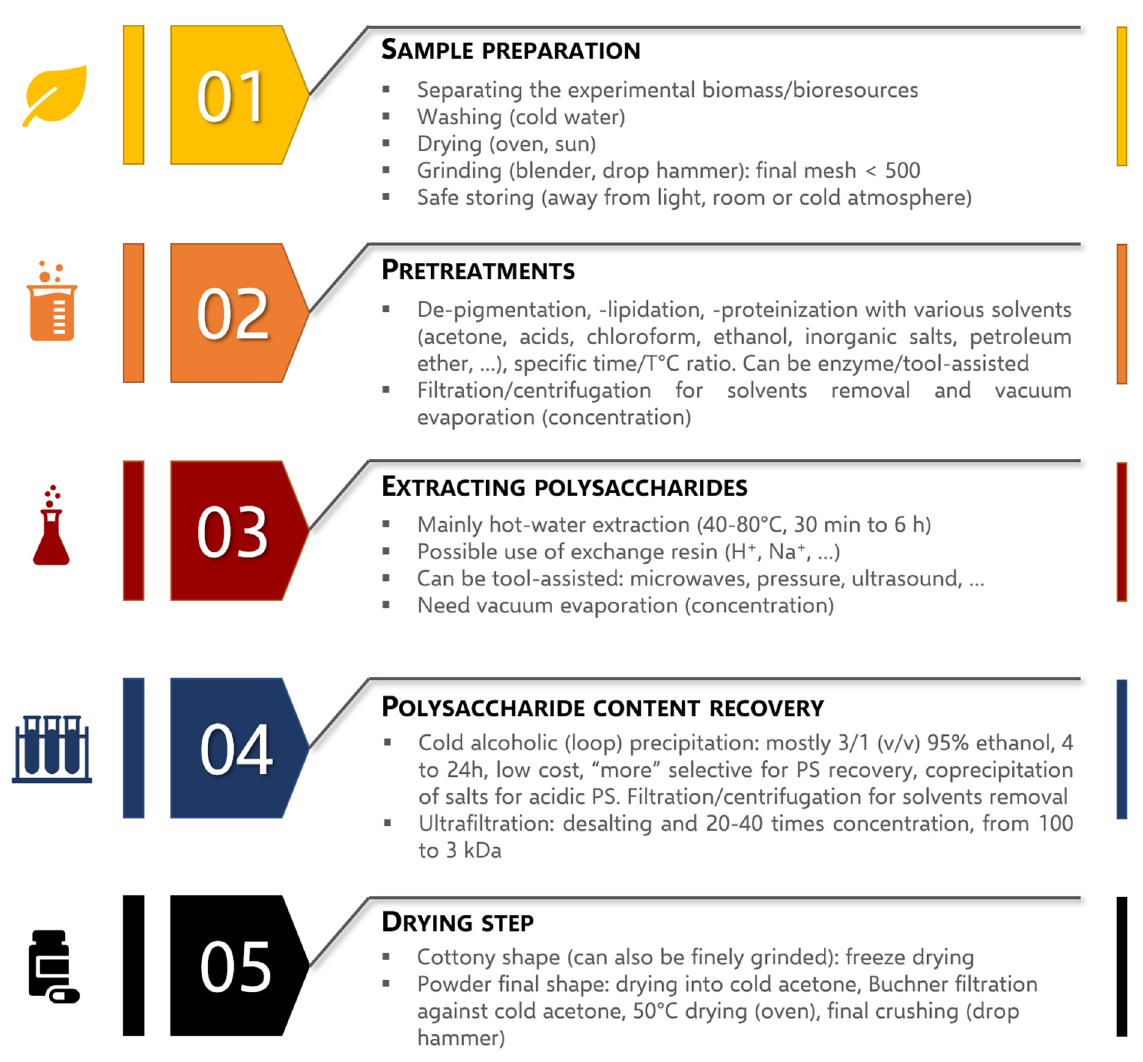
Figure 2. Main strategies for extracting enriched-polysaccharide fractions. A corrective formula should be used for enhancing the results accuracy [47]. Non- carbohydrate substituents such as (a) pyruvate, (b) methyl and acetyl, and (c) sulfate groups can be quantified by performing respectively (a) the method of 2,4-dinitrophenyl- hydrazine [48], (b) High-Performance Liquid Chromatography (HPLC) methodology prior a saponification step and/or 1 H Nuclear Magnetic Resonance (NMR) (most reliable method for determining methyl and/or acetyl groups) [49], (c) the turbidimetric gela- tin/BaCl 2 method [50] and/or the azure A method [51]. Finally, proteins and polyphenols contents can be determined using respectively the “Smith”, “Bradford” or “Lowry” meth- ods [52–54] and the Folin–Ciocalteu assay [55]. Note that the presence of salts, ashes and moisture should be considered. Fourier Transformed InfraRed (FTIR) spectroscopy could also provide useful information concerning vibrationally functional groups of polysac- charides.